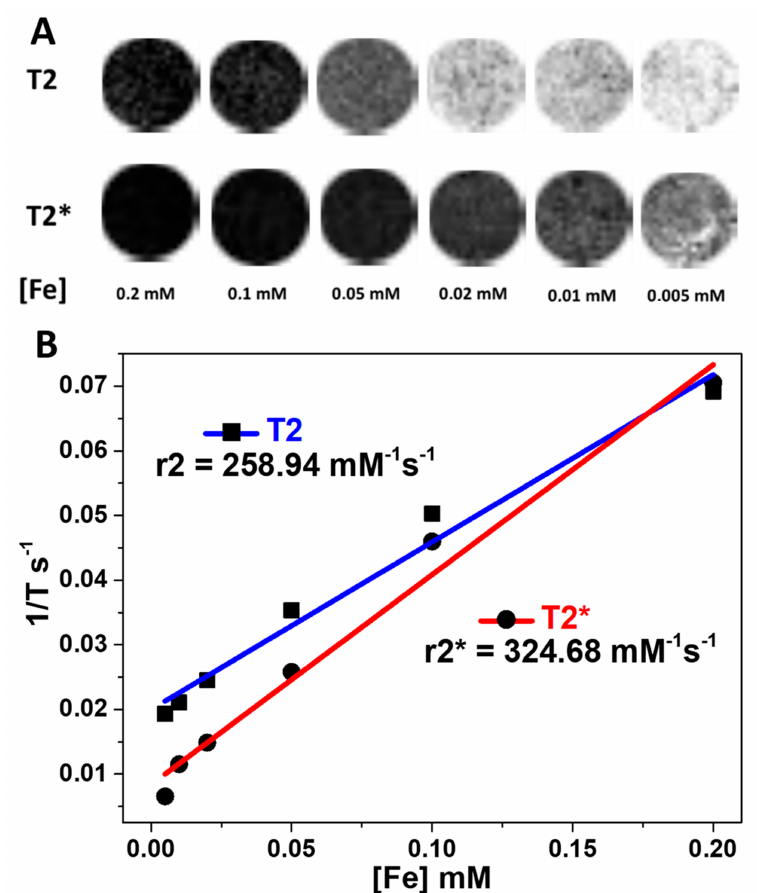
Figure 10. ( A ) T2 and T2* weight images of an agar phantom template, with crescent concentrations of Fe coupled to HMMSN hybrid magnetic mesoporous nanorods. ( B ) Relaxivity values obtained with T2 and T2* weight